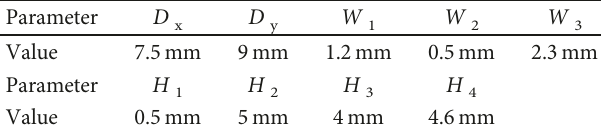
Table 1: Parameters of the equivalent circuit. Table 2: Optimal parameters of the FSS